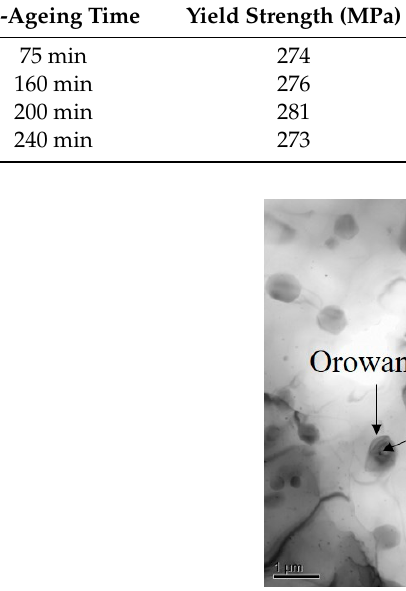
Figure 8. The engineering stress-strain curves of the rolled AZ80 magnesium alloys pre-aged for 75, 160, 200 and 240 min. Table 1. Comparable mechanical properties of the rolled AZ80 sheets pre-aged for various time.